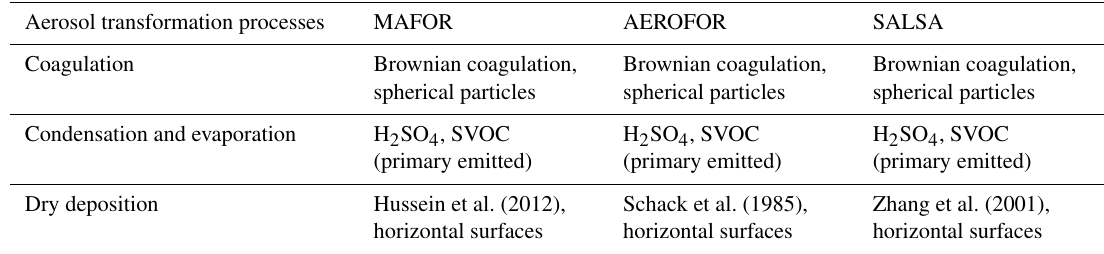
Brownian coagulation, spherical particles H 2 SO 4 , SVOC (primary emitted) Schack et al. (1985), Zhang et al. (2001), horizontal surfaces